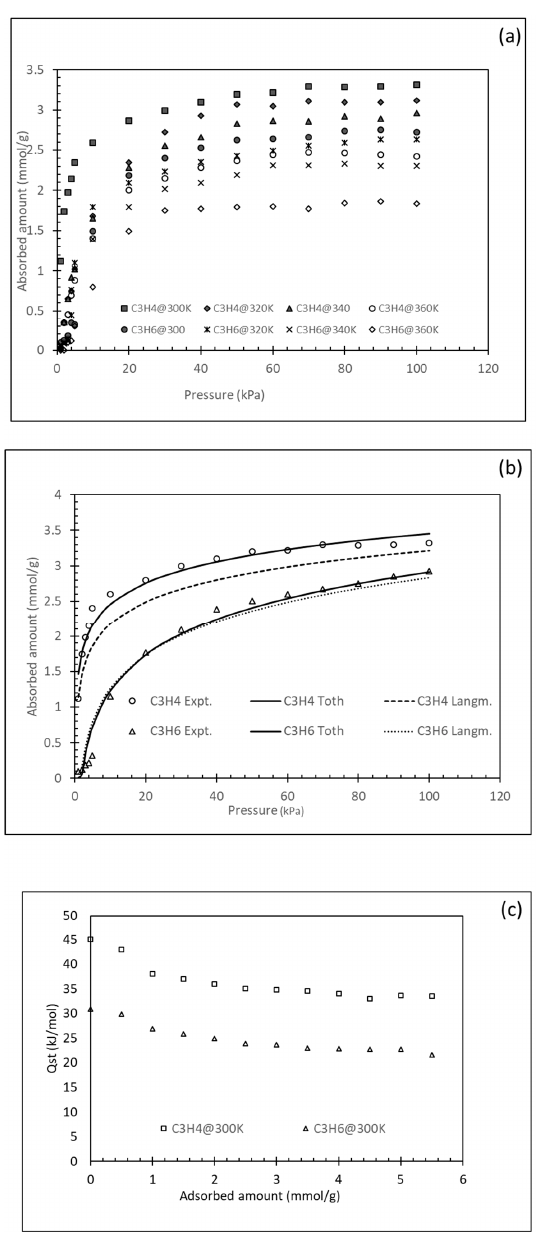
Figure 5. Single gas adsorption. ( a ) Uptake adsorption amounts at different temperatures and for the two pure propyne and propylene gases; ( b ) experimental and model fitted isotherms for propyne and propylene at 300 K; ( c ) isosteric heats of adsorption for propyne and propylene adsorption at 300 K.